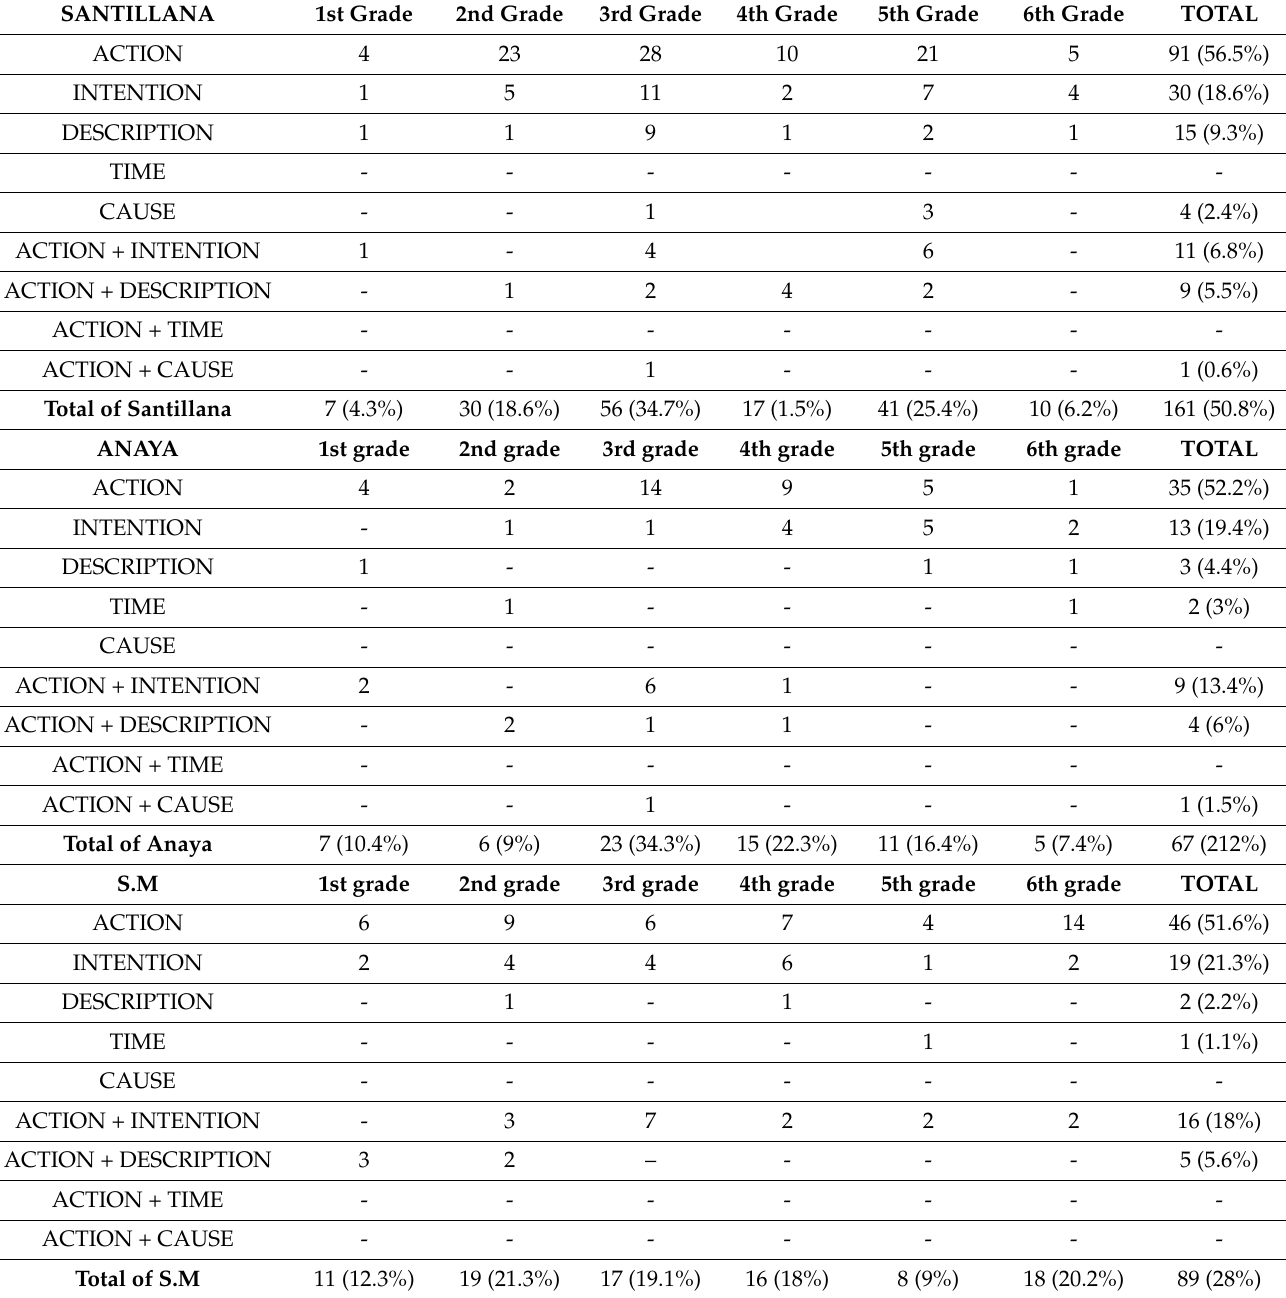
Table 8. Results of the frequency and variability of problems with situational